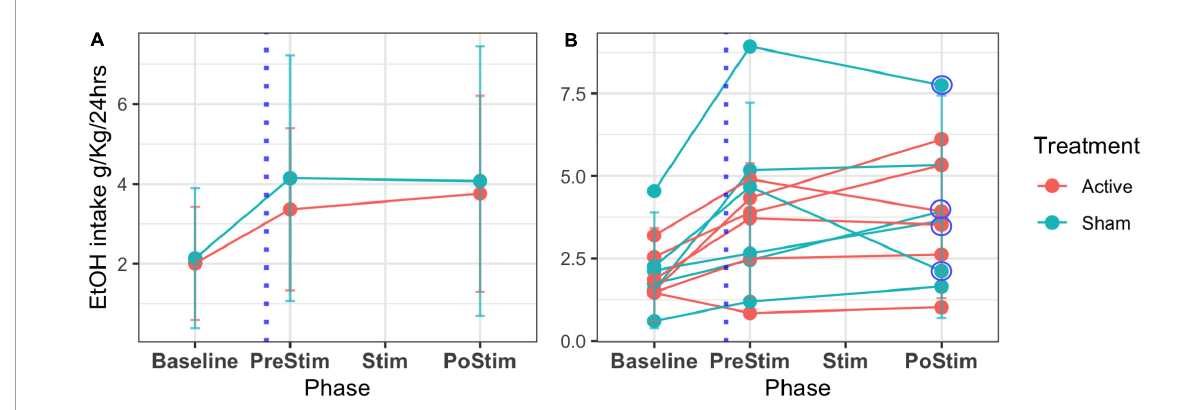
FIGURE8 Mean EtOH intake and SD across phases of follow-up of the 12 rats. T1 or IA2BC development (baseline) is the 45 days where alcohol is offered in an elective model. The time for the surgery is marked with a blue dotted line (T2 or abstinence). T3 (relapse) comprehends a period before the stimulation treatment (PreStim) and the application of treatment under two conditions: sham/active (Stim) and a period of follow-up after the treatment (PostStim). (A) Mean and SD of the groups’ intake. (B) Individual mean ethanol intake and SD. Circled are the decreasing intakes between PreStim and PostStim evaluation of four